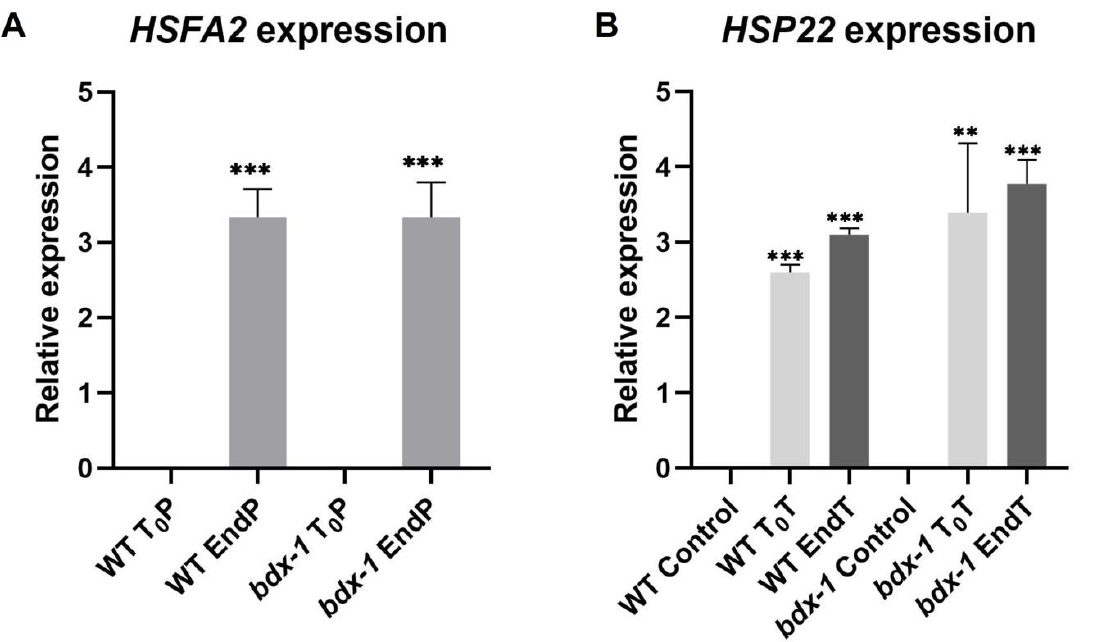
Figure 5. Expression of thermomemory genes in the bdx -1 line. ( A ) HSFA2 expression at the end of priming compared to T 0 P in each line. The expression level is similar in WT and bdx -1. ( B ) HSP22 expression at the beginning and the end of triggering, compared with plants without treatment. For HSFA2 , the expression values are relative to T 0 P expression and for HSP22 , to WT control. Error bars indicate S.D. (n = 3). Statistical analyses were performed using Student’s t -test. Asterisks indicate statistically significant differences to T 0 P and to WT control (** p < 0.01, *** p < 0.001).